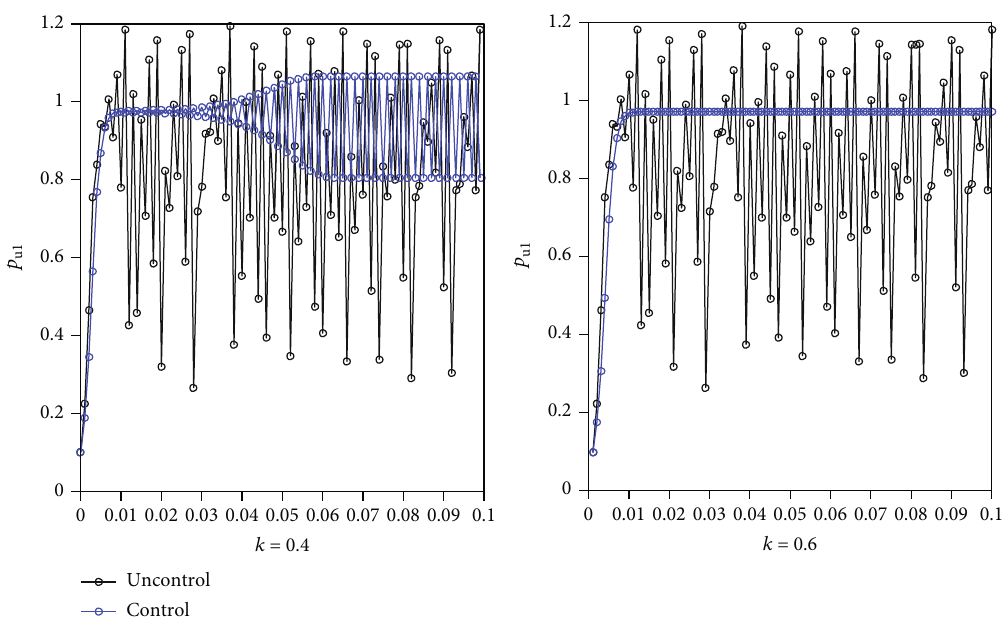
= 2 : 522, and λ = 1 : 2 1 2